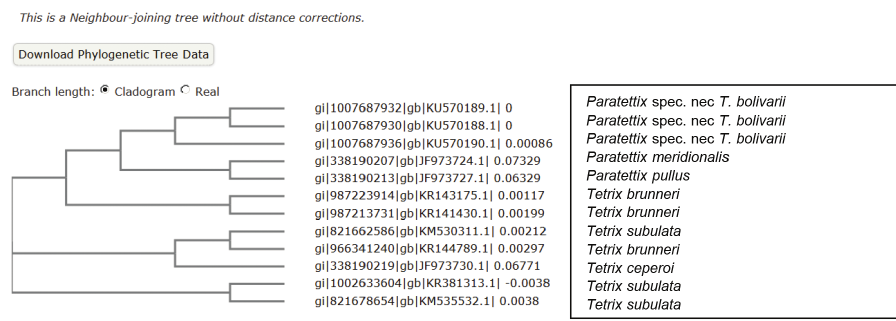
Figure 1. Neighbour-joining tree based upon the COI data, illustrating the clustering of the Chinese samples by Zhao et al. (2016) together with Paratettix and not Tetrix species, data extracted from the Barcoding of life